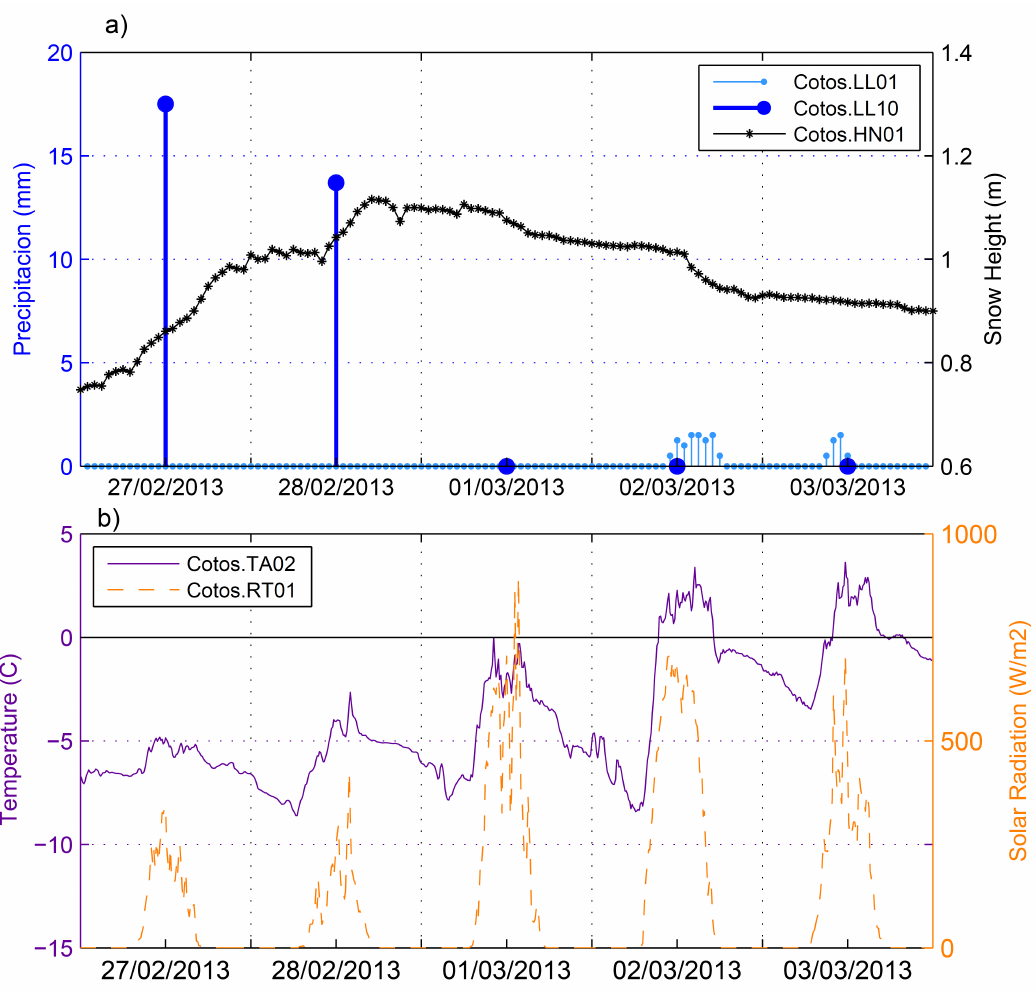
Figure 11. ( a ) Precipitation observed using both a manual (Cotos.LL10) and a non-heated tipping bucket (Cotos.LL01) rain gauge, and the snow height in Cotos site for the same period; ( b ) Air temperature (Cotos.TA02) and solar radiation (Cotos.RT01) observed at Cotos